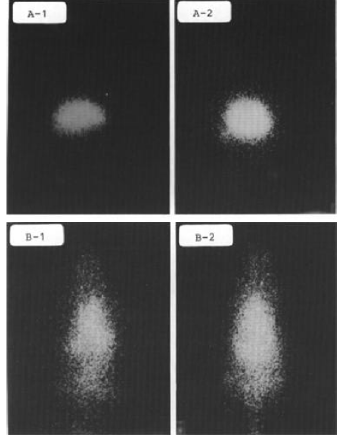
Figure 1. Whole body images of 45 Ti-phytate ( A ) and 45 Ti-DTPA (diethylenetriaminepentaacetic) ( B ) acquired 10 minutes ( A1 and B1 ) and 60 minutes ( A2 and B2 ) after injection in rats. Images published by Ishiwata et al. in 1981 [28].